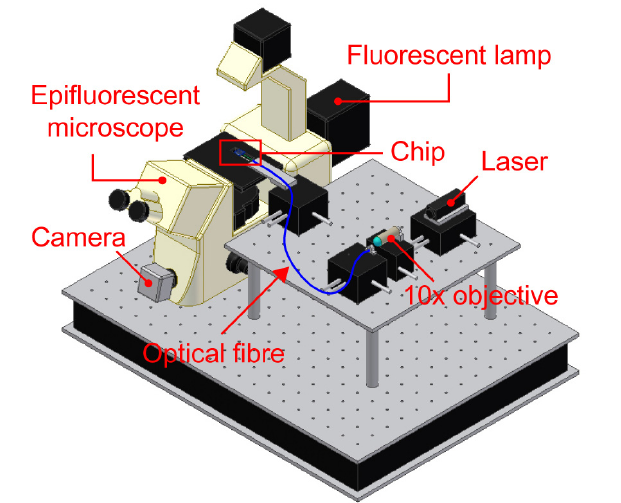
Figure 4. Schematic view of the experimental set-up for fluorescence experiments. The laser light is coupled to the optical waveguides in the chip through an optical fiber. Fluorescence images of the chip are taken with a dedicated